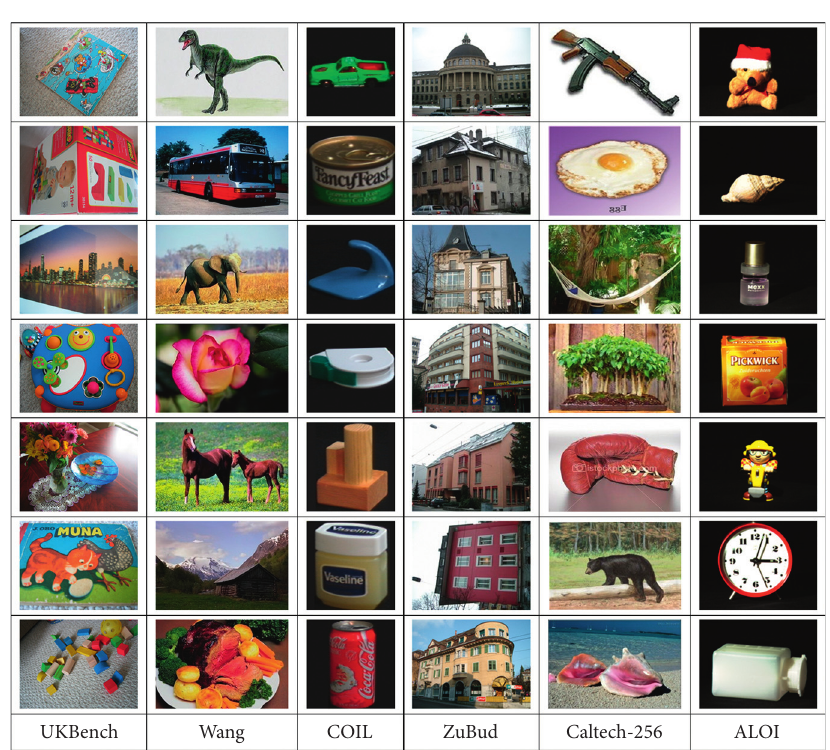
Figure 3: Sample images from standard